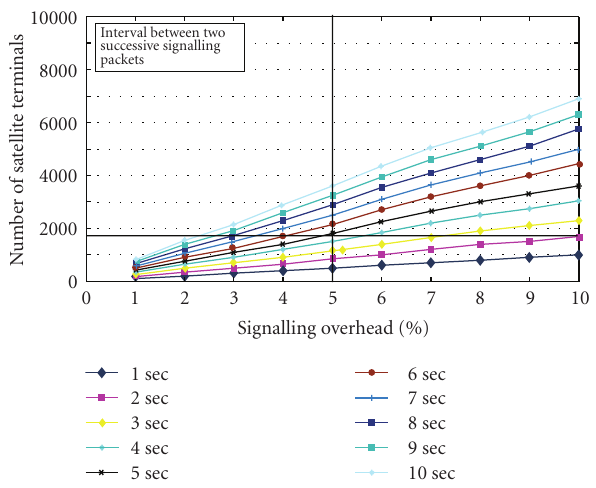
Figure 11: Scalability of the proposed framework in terms of supported terminals.